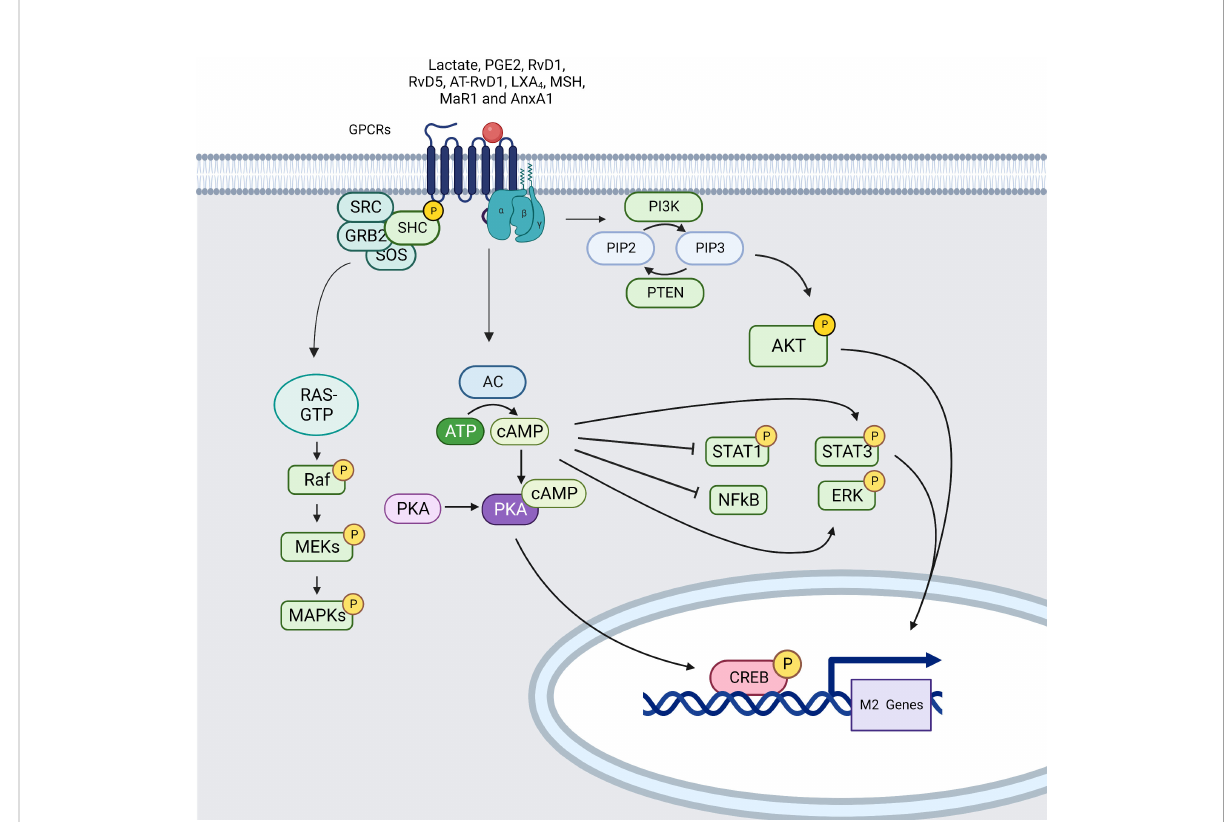
FIGURE 6 Simpli fi ed signaling pathway induced by GPCRs in macrophages (created using BioRender ®